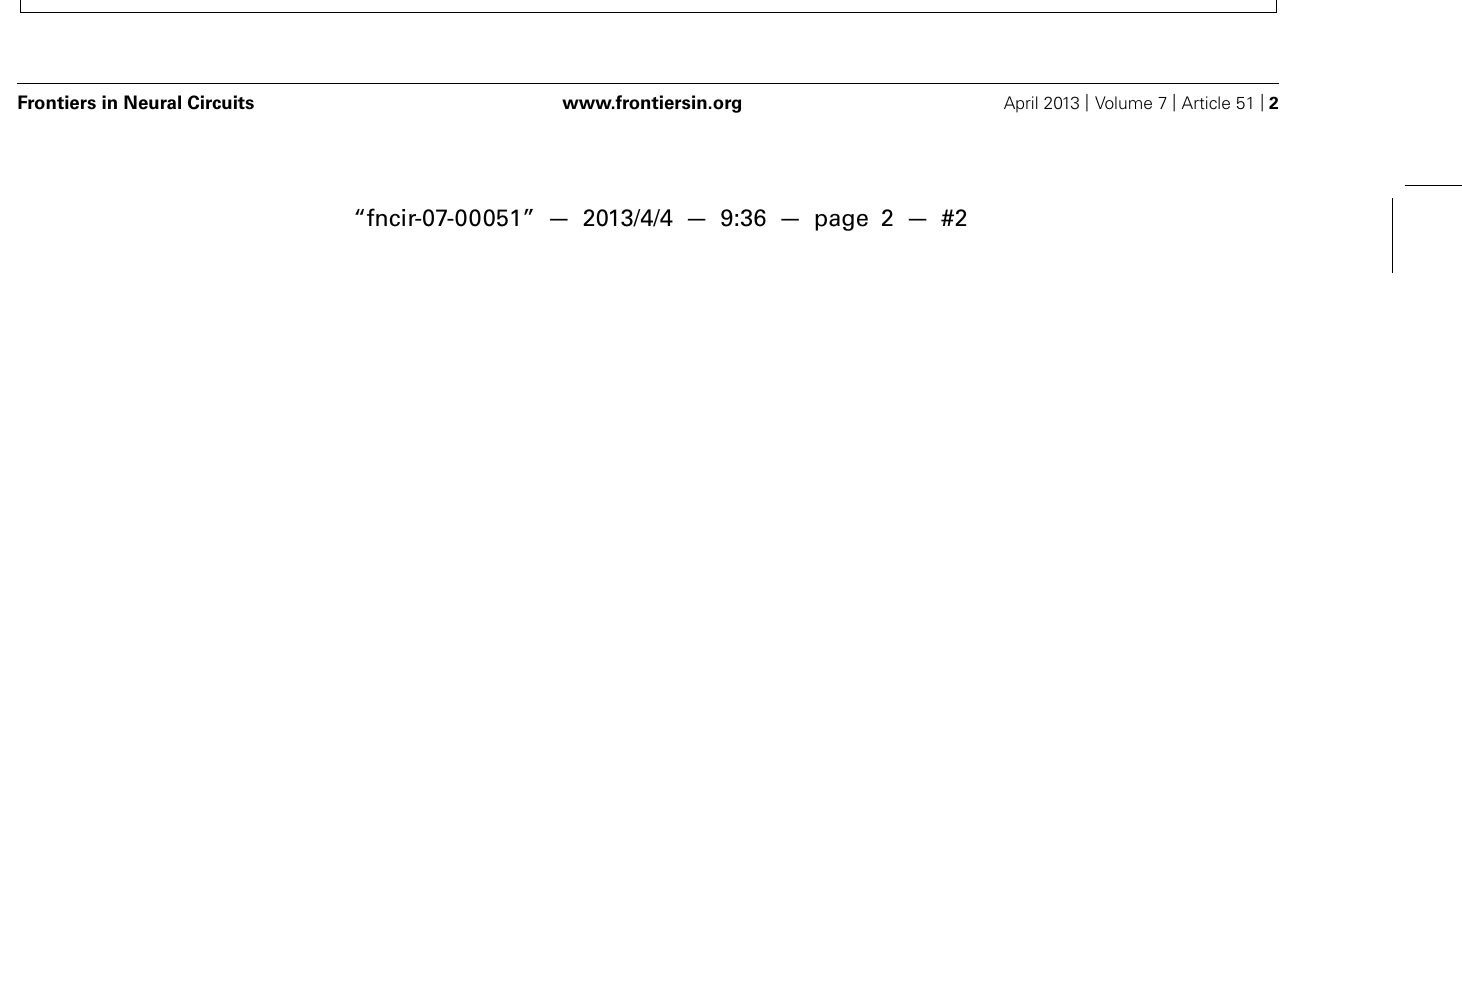
FIGURE 1 | Schematic of the two hypotheses for neural coding during a double-step. (A) Top :The theoretical double-peaked velocity profile of a double-step trial (black) can be decomposed into the sum of a primary velocity profile (light gray) and an overlapping, secondary velocity profile (dark gray); middle : Under the default “Summed” hypothesis, neural firing is predicted to track the observed velocity profile, preceding it at a fixed lead; bottom :The alternative “Replaced” hypothesis predicts that the neural firing